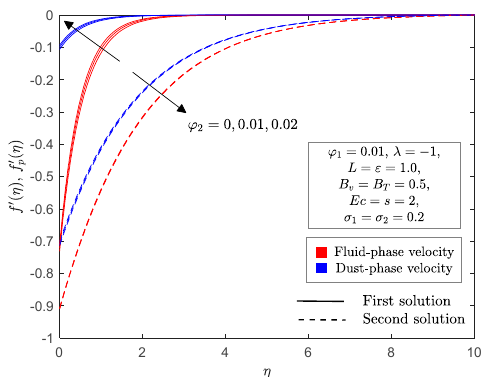
− toward the permeable stretching/shrinking parameter λ . The occur- number 1/2 Re x σ and thermal, σ ) consequently diminishes the lo- rence of slip parameters (velocity, 1 2 ( ) 0 λ< , but increases it for a cal skin friction when the sheet is shrinking ( ) ( ) ϕ ( ) , f f η η′′ for selected values of Figure 6. 0 λ> in both solutions. In Figure 9, the local Nusselt number shows a ( ) ( ) , 2 stretching sheet p ϕ f f η η′′ for selected values of Figure 6. Figure 6. f (cid:48) ( η ) , f p (cid:48) ( η ) for selected values of ϕ 2 . 2 p declining trend in both solutions, along with a simultaneous increment of slip parameters ( ) , σ σ . A simultaneous increase in both the velocity and thermal slip parameters post- 1 2 pones boundary layer separation, as shown in Figures 8 and 9. A diminished momentum boundary layer thickness was observed in the first solution when the velocity slip param- σ increased on the dusty hybrid nanofluid for both phases, as shown in Figure 10; eter 1 however, the opposite occurred for the second solution. Note that when , 0.2, 0 σ σ= = , it corresponds to velocity it corresponds to thermal slip only, while when 2 slip only. On the other hand, Figures 11 and 12 illustrate the variation of the temperature ( ) θ η ( ) θ η when velocity σ and thermal σ slip profile of the fluid and dust phases p 1 2 parameters fluctuate from 0 to 0.2 , respectively. It is interesting to observe from these figures that for the first and second solutions, the thermal boundary layer thickness de- creased with an increase in velocity and thermal slip parameters. However, we did not σ , as this parameter caused no plot the velocity profiles for thermal slip parameter 2 ( ) ( ) , θη θ η for selected values of ϕ Figure 7. changes in the velocity profiles. p 2 ( ) ( ) Figure 7. θ ( η ) , θ p ( η ) for selected values of ϕ 2 . θη θ η for selected values of ϕ , Figure 7. p 2 ( Figures 8 and 9 show the impact of the no-slip parameter and slip pa- ( Figures 8 and 9 show the impact of the no-slip parameter